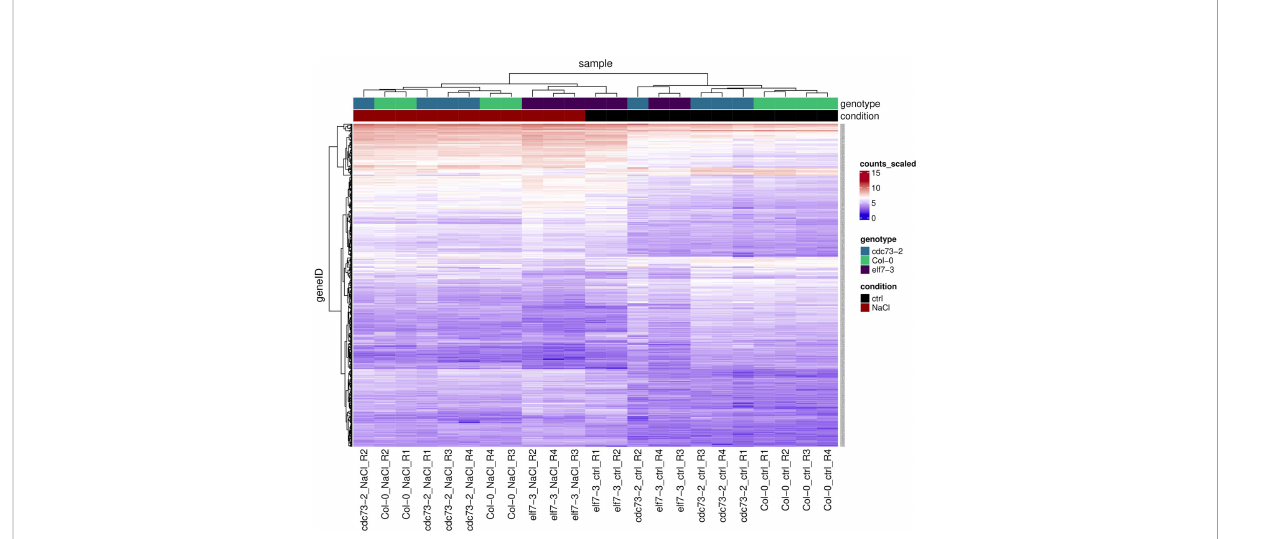
FIGURE 4 Heatmap and hierarchical clustering of the 500 most variable genes identi fi ed by transcript pro fi ling of elf7-3 and cdc73-2 relative to Col-0 upon NaCl treatment. These genes were selected from the scaled counts of the count table using the subread package “ featureCounts ” and the count table includes the counts for all replicates, conditions and genotypes. Relative transcript abundance is shown as heatmap using the indicated scale (LFC of scaled counts). Genotypes and condition (ctrl: control; NaCl: 3h 100 mM NaCl) are colour-coded on